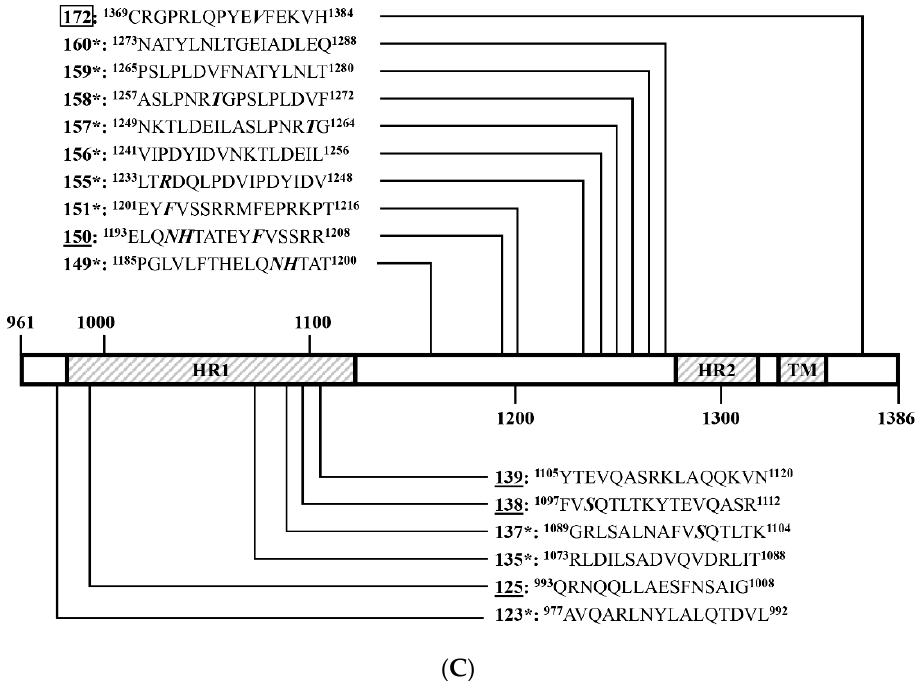
Figure 8. Distribution of positive peptides on SF1 SD2014 ( A ), SF2 SD2014 ( B ), and SF2 SD2014 ( C ). The horizontal bar represents the primary structure of S SD2014 protein, of which the domains were framed as in Figure 1. Numbers assigned to the 16-mer or 10-mer peptides are the same in Figure 7. The numbers underlined mark peptides that are anti-S SD2014 serum-positive. The numbers in boxes mark the peptides that are anti-S CV777 serum-positive; Numbers with “*” mark peptides recognized by both anti-S CV777 serum and anti-S SD2014 serum (Co-RecoMers). The positions of each peptide in S SD2014 protein are indicated with superscripts. The arrow shows the boundary of S1/S2.